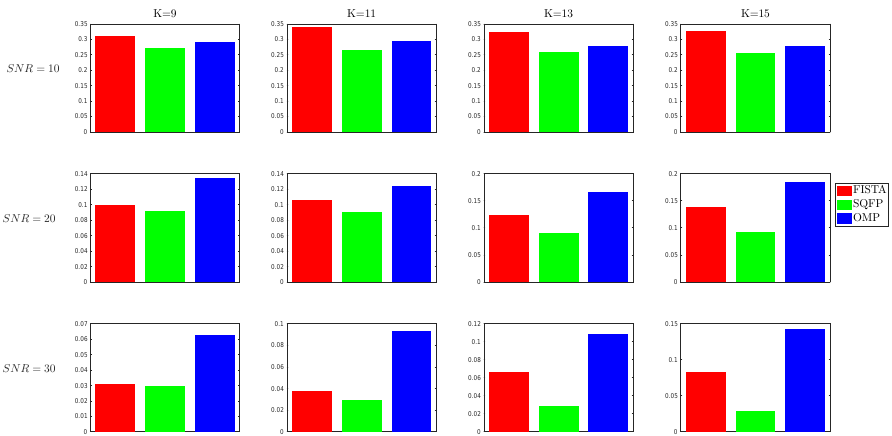
Figure 8. Mean errors for all algorithms, dictionary size 80 × 400, condition number